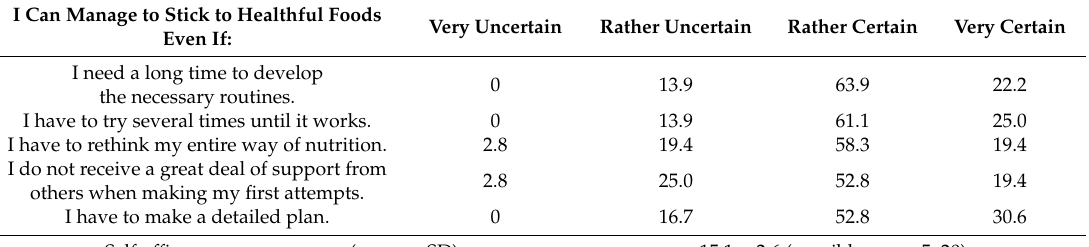
Table 3. Reported self-e ffi cacy of low-income Iowa women to maintain a healthy diet ( n = 36).